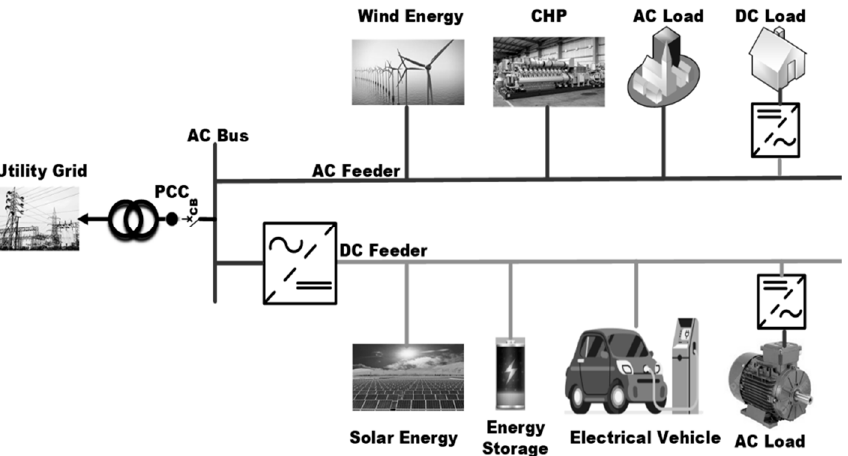
Figure 3. A hybrid microgrid (AC and DC systems).